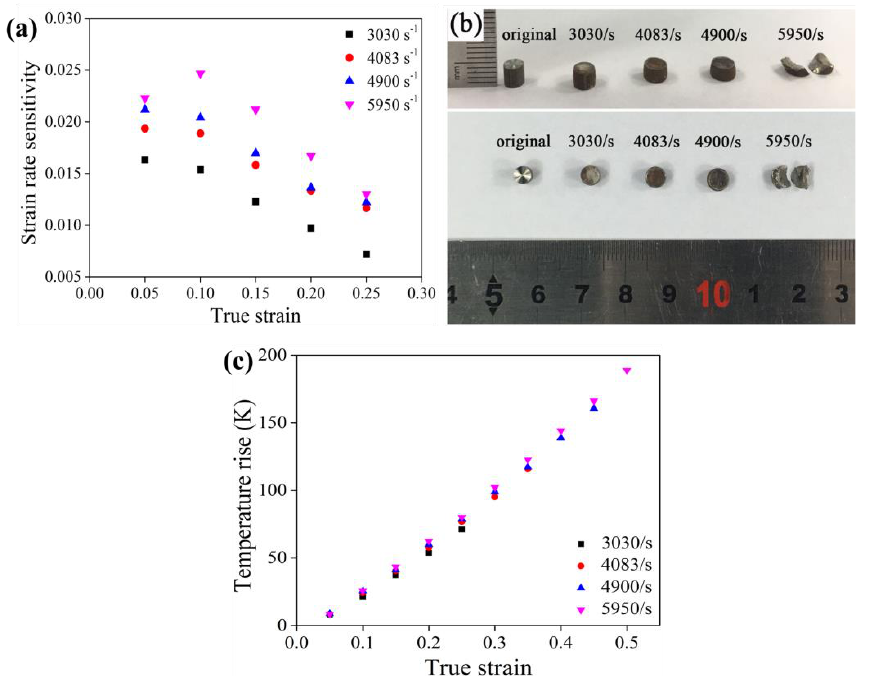
Figure 3. ( a ) Strain rate sensitivity at various strain rates as a function of true strain; ( b ) as-received and deformed specimens; ( c ) temperature rise under different strains.